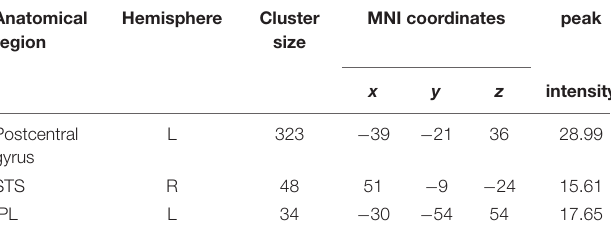
TABLE 2 | Significant clusters ( p < 0.01, cluster size > 30) correlated with the abstract emotion model from searchlight analysis. Anatomical region